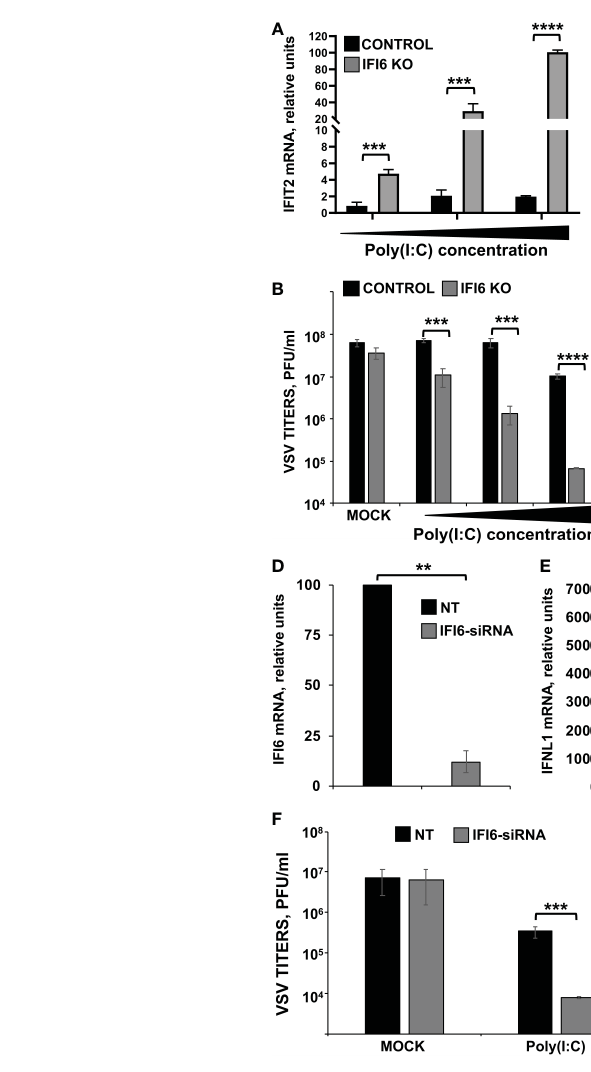
poly(I:C) concentration, compared to non-transfected control HAP-1 cells. Interestingly, rVSV-GFP titers were decreased by ~1,000-fold in poly(I:C)-transfected IFI6 KO HAP-1 cells, in comparison to poly(I: C)-transfected control HAP-1 cells (Figure 4B). Moreover, to analyze